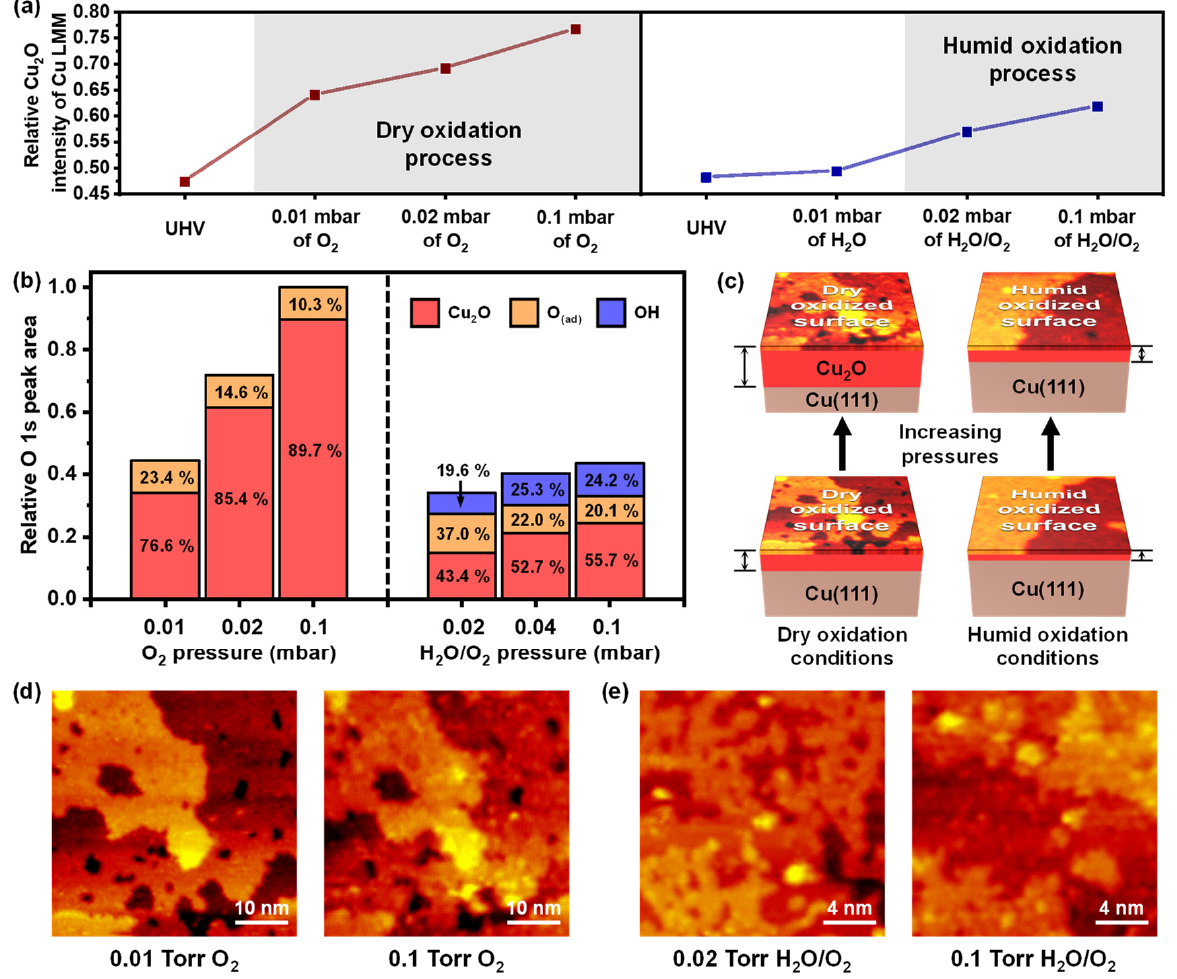
Figure 5. ( a ) Relative peak intensity histogram of Cu 2 O/Cu ratio from Cu LLM spectra under different oxidation reaction conditions. ( b ) Relative peak area histogram of O 1s NAP-XPS core-level measurements under dry and humid oxidation process. ( c ) Schematic representations of Cu(111) oxidation process for the surface fully covered by dry oxidized surface under increased O 2 gas pressure and covered by humid oxidized surface under increased H 2 O/O 2 gas mixture pressure. ( d ) and ( e ) NAP-STM images under different oxidation conditions used for surface STM images in ( c ).